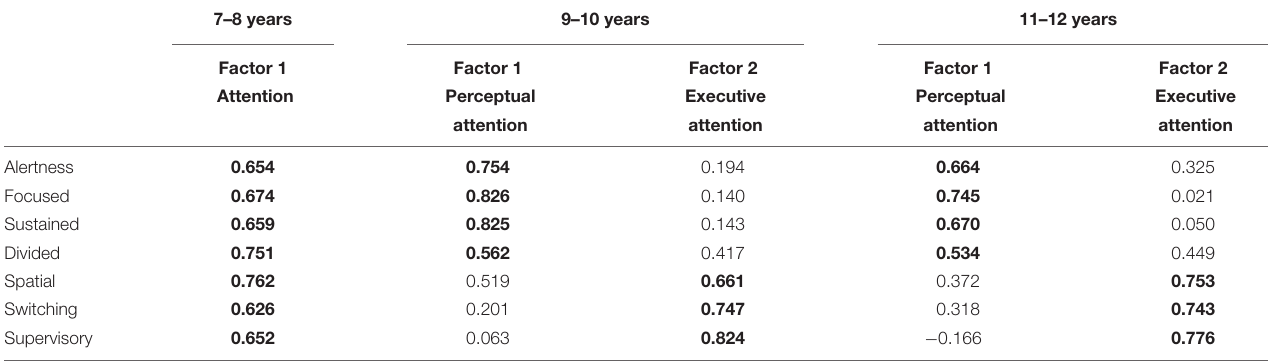
TABLE 5 | Principal component analysis of attention structure in the three age